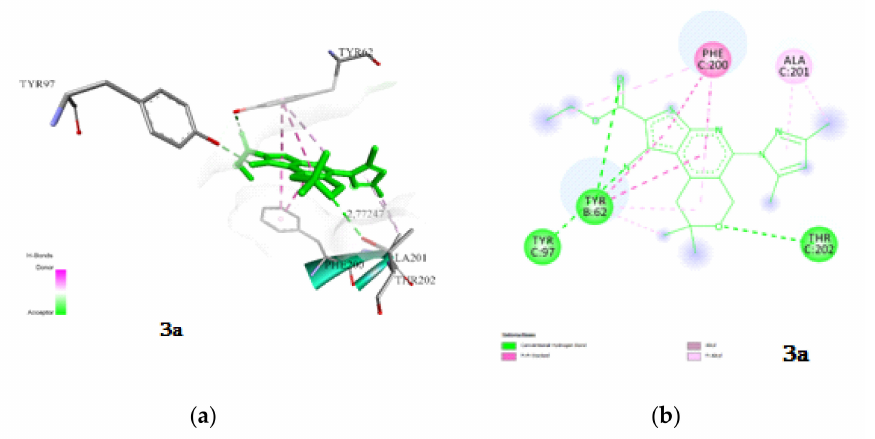
Figure 3. Visualization of the interaction of 3a with GABA A ; ( a ) spatial orientation and charac- ter of the interaction; ( b ) conformational map of complexation. Green lines are hydrogen bonds, violet − hydrophobic interactions.